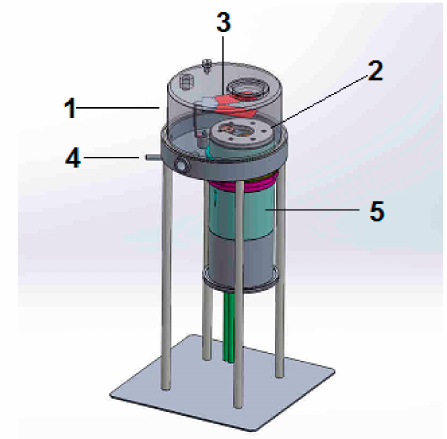
Figure 1. Design of the laboratory measuring chamber: 1—chamber housing; 2—measuring head; 3—samples; 4—feed to vacuum pump; 5—supporting